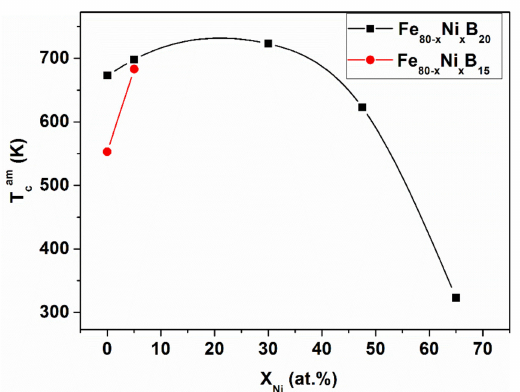
Figure 9. Curie temperature T Cam for Fe 85-x Ni x B 15 and Fe 80-x -Ni x B 20 glassy alloys versus Ni content. Adopted from [65], with permission from the Institute of Physics of the Polish Academy of Sciences,